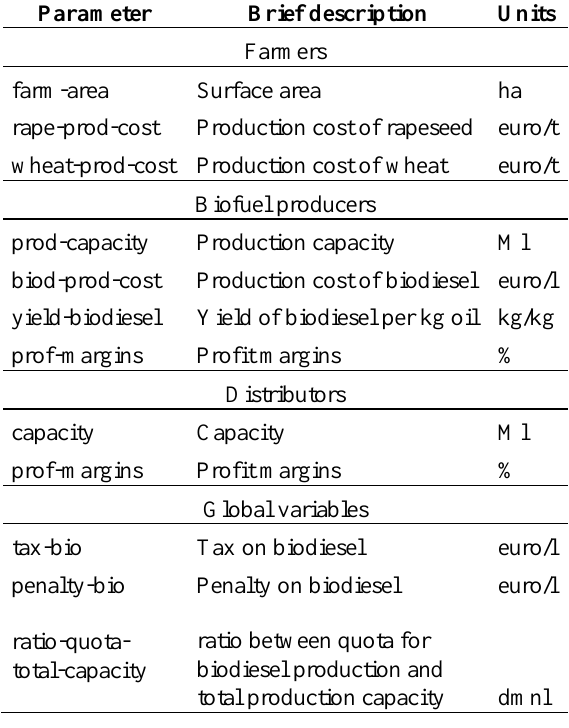
Table 1. Main state variables of the agents and global variables